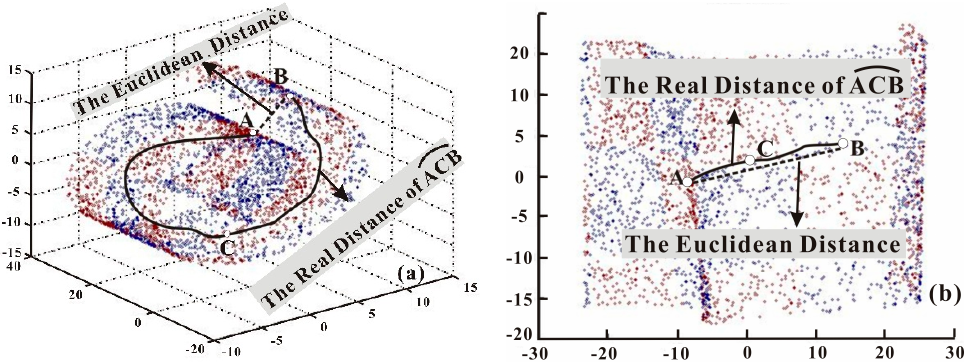
Figure 1. ( a ) Data of a Swiss roll; and ( b ) the result of mapping the Swiss roll data by MVU. (Note: Figure 1 is based on the original figure of Weinberger and Saul [31])